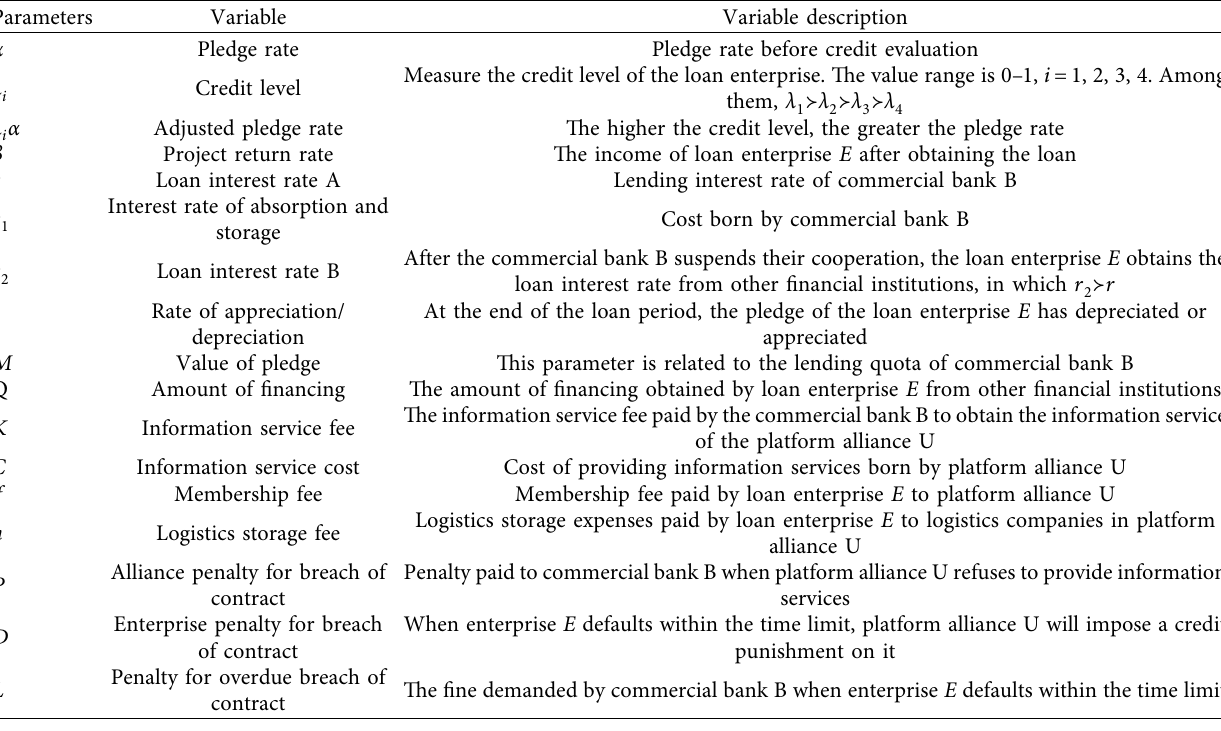
Table 1: Game model parameter settings.